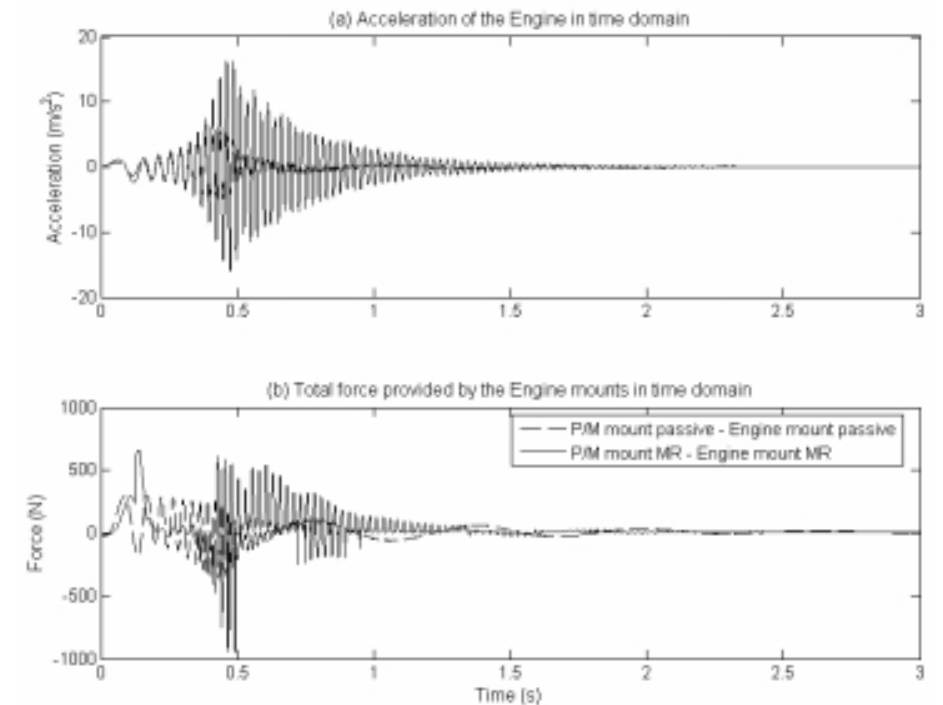
Fig. 9. Acceleration of the engine in time domain (a) and force provided by the engine mounts in time domain (b).